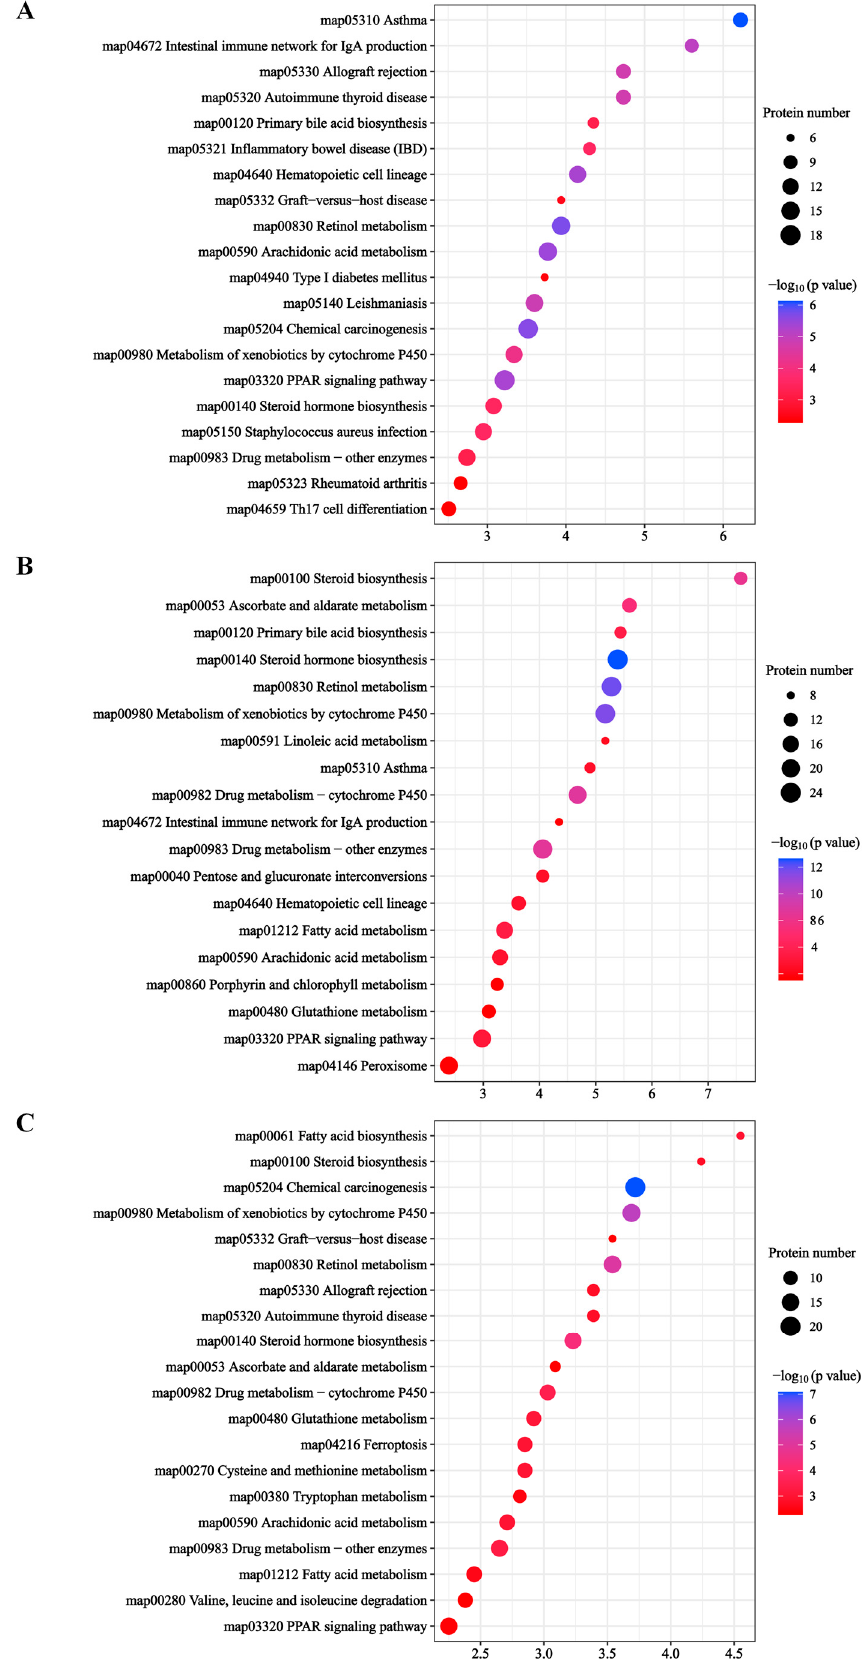
Figure 4. KEGG enrichment results of DEPs in LZT/JZT ( A ), SNT/JZT ( B ) and SNT/LZT ( C ).